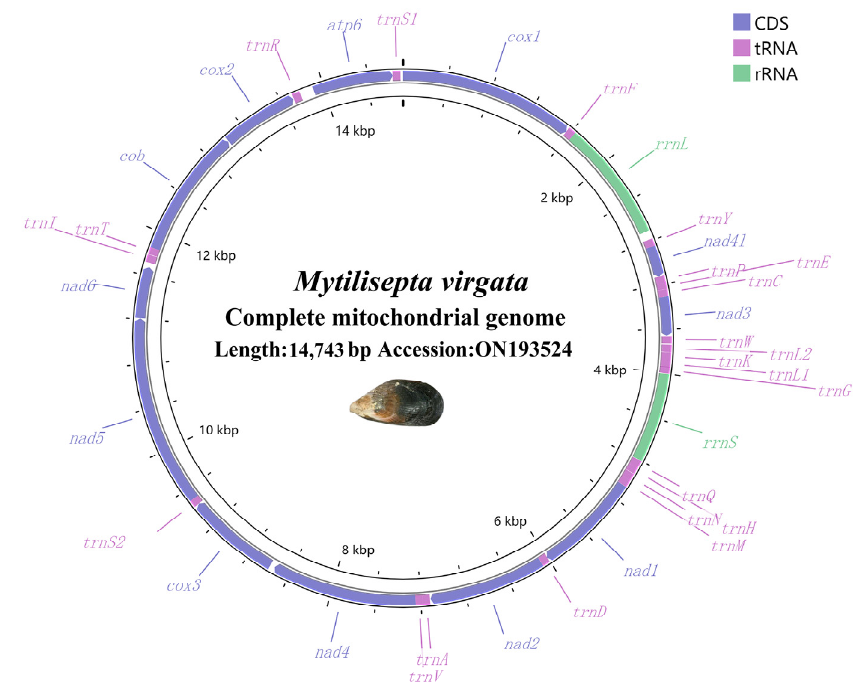
Figure 1. Circular mitogenome map of the mitochondrial genome of M. virgata . Protein coding, ribosomal, and tRNA genes are shown with standard abbreviations. Arrows indicate the orientation of gene transcription. Table 1. Skewness of the M. virgata mitogenome.